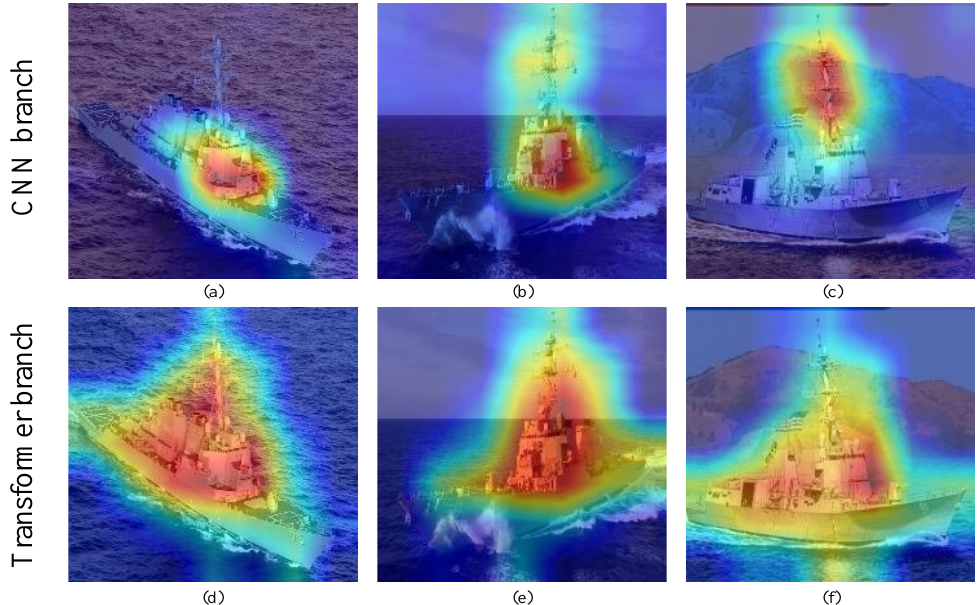
Figure 9. Class activation maps: ( a ) CNN branch in Arleigh Burke-class Destroyer, ( b ) CNN branch in Arleigh Burke-class Destroyer, ( c ) CNN branch in Arleigh Burke-class Destroyer, ( d ) Transformer branch in Arleigh Burke-class Destroyer, ( e ) Transformer branchin Arleigh Burke-class Destroyer, ( f ) Transformer branch in Arleigh Burke-class Destroyer.